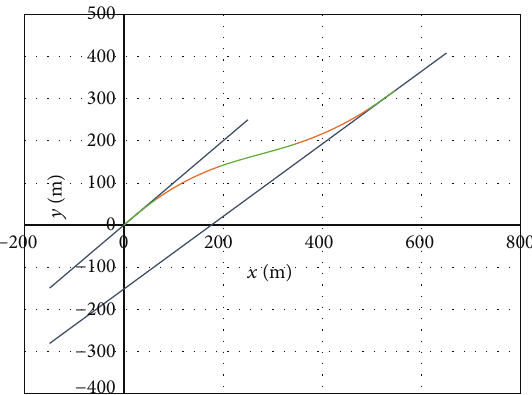
Figure 7: Visualization of the designed geometric system (Example